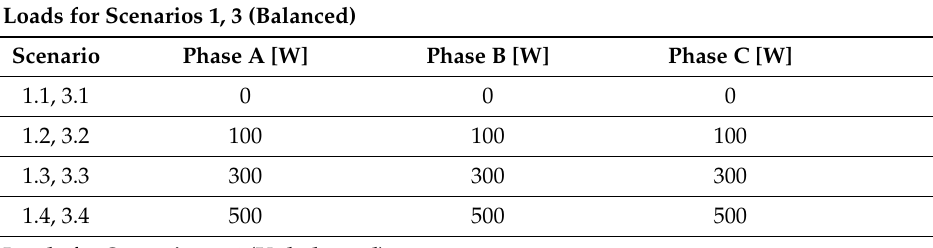
Table 3. Load power settings for AC Scenarios